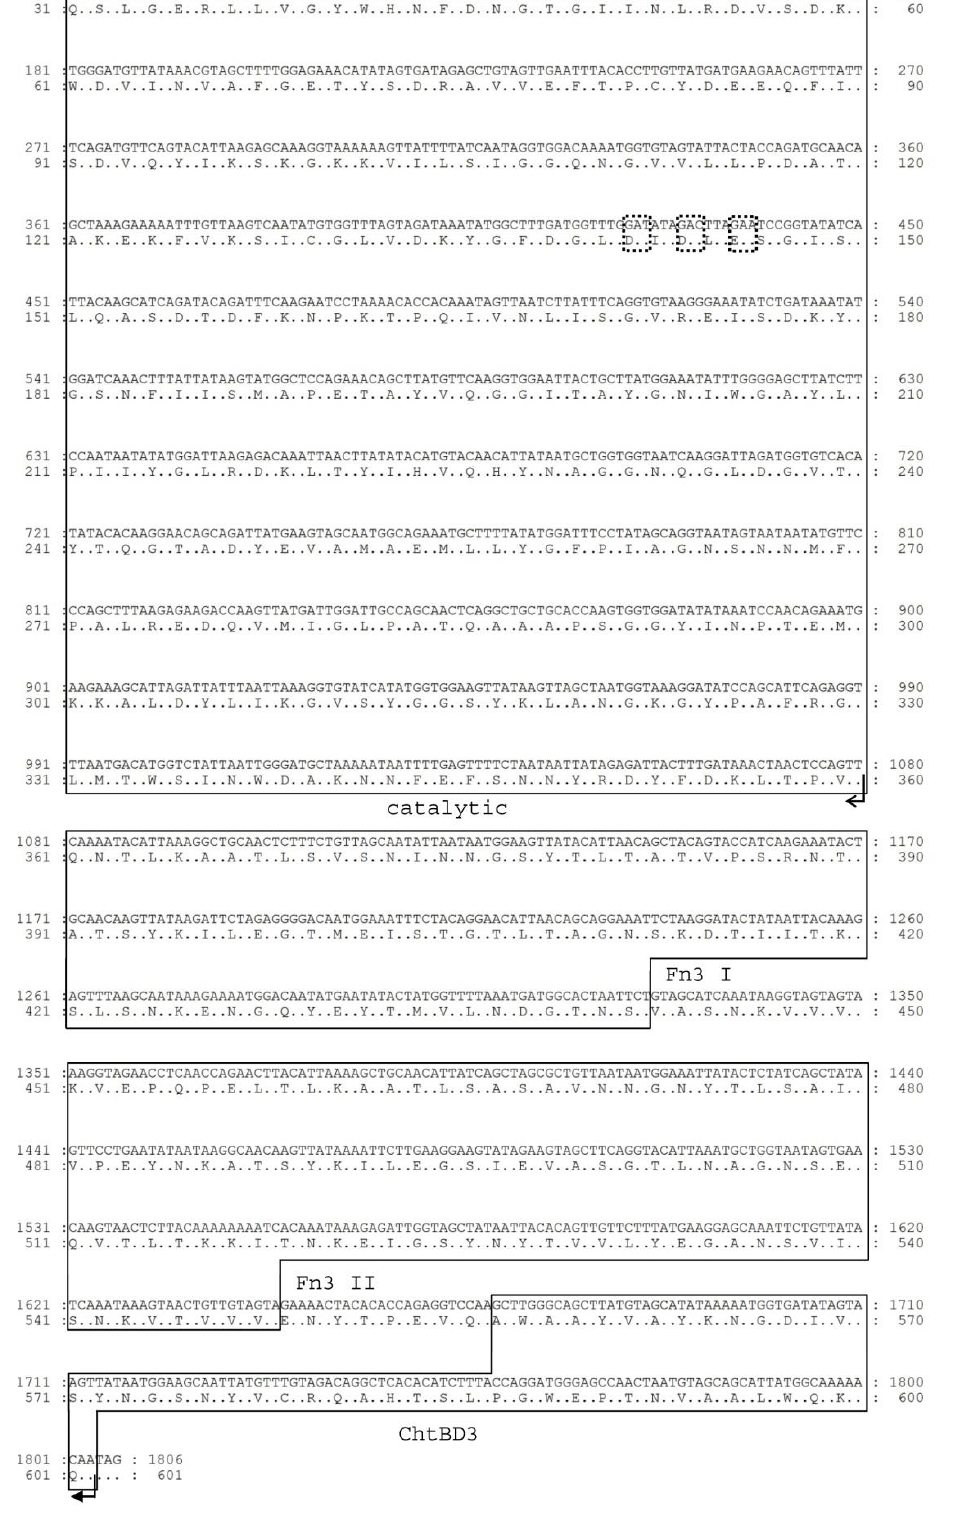
Figure 1. DNA and amino acid sequence of chitinase Chit62J4. The expected domain boundaries and catalytic amino acids are marked. The construct boundaries of rChit62J4 and rChit62J4cat are marked with filled and line arrows, respectively.